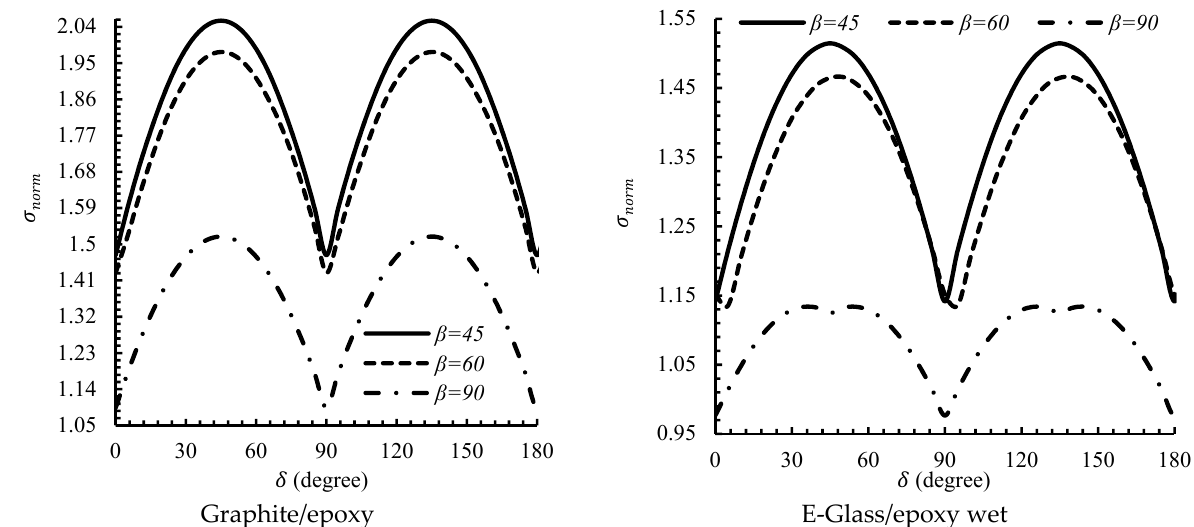
Figure 11. Effect of heat flux angle on the maximum normalized stress in different values of β .